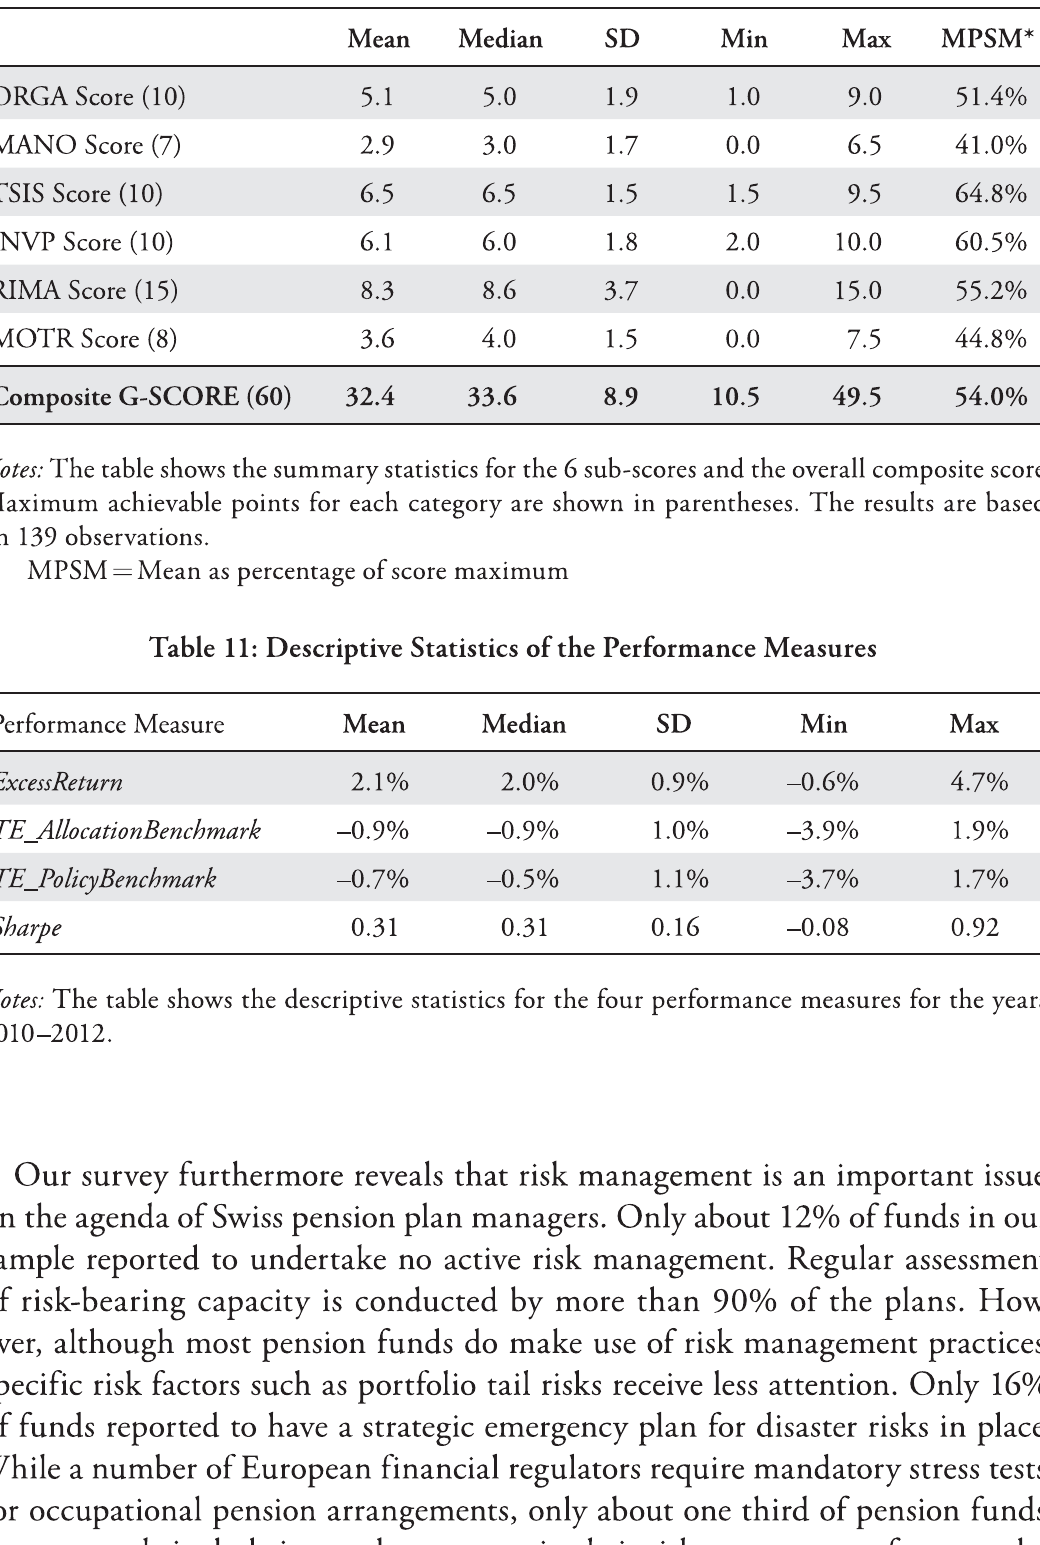
Table 10: Summary Results of the Swiss Pension Fund Governance Score